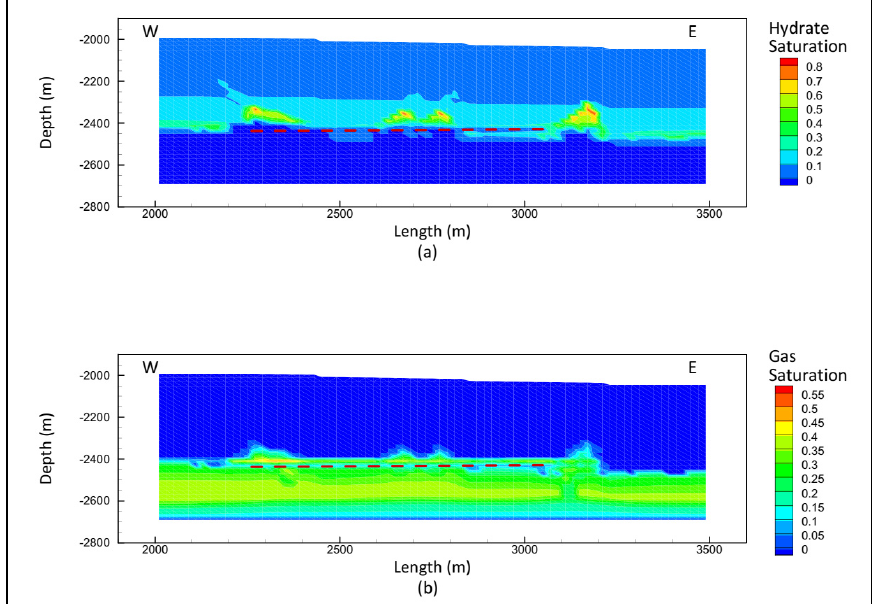
Figure 8. ( a ) The hydrate distribution is not impacted by the steady production of 0.1 kg/s for 180 days in the reservoir using horizontal production well (red dotted line). The maximum hydrate saturation remains the same along faults, although the total hydrate in the reservoir decreases by 5 × 10 4 kg. ( b ) The underlying gas layer contributes to the production as much as the hydrate layer, and that facilitates upward migration into the hydrate stability zone.